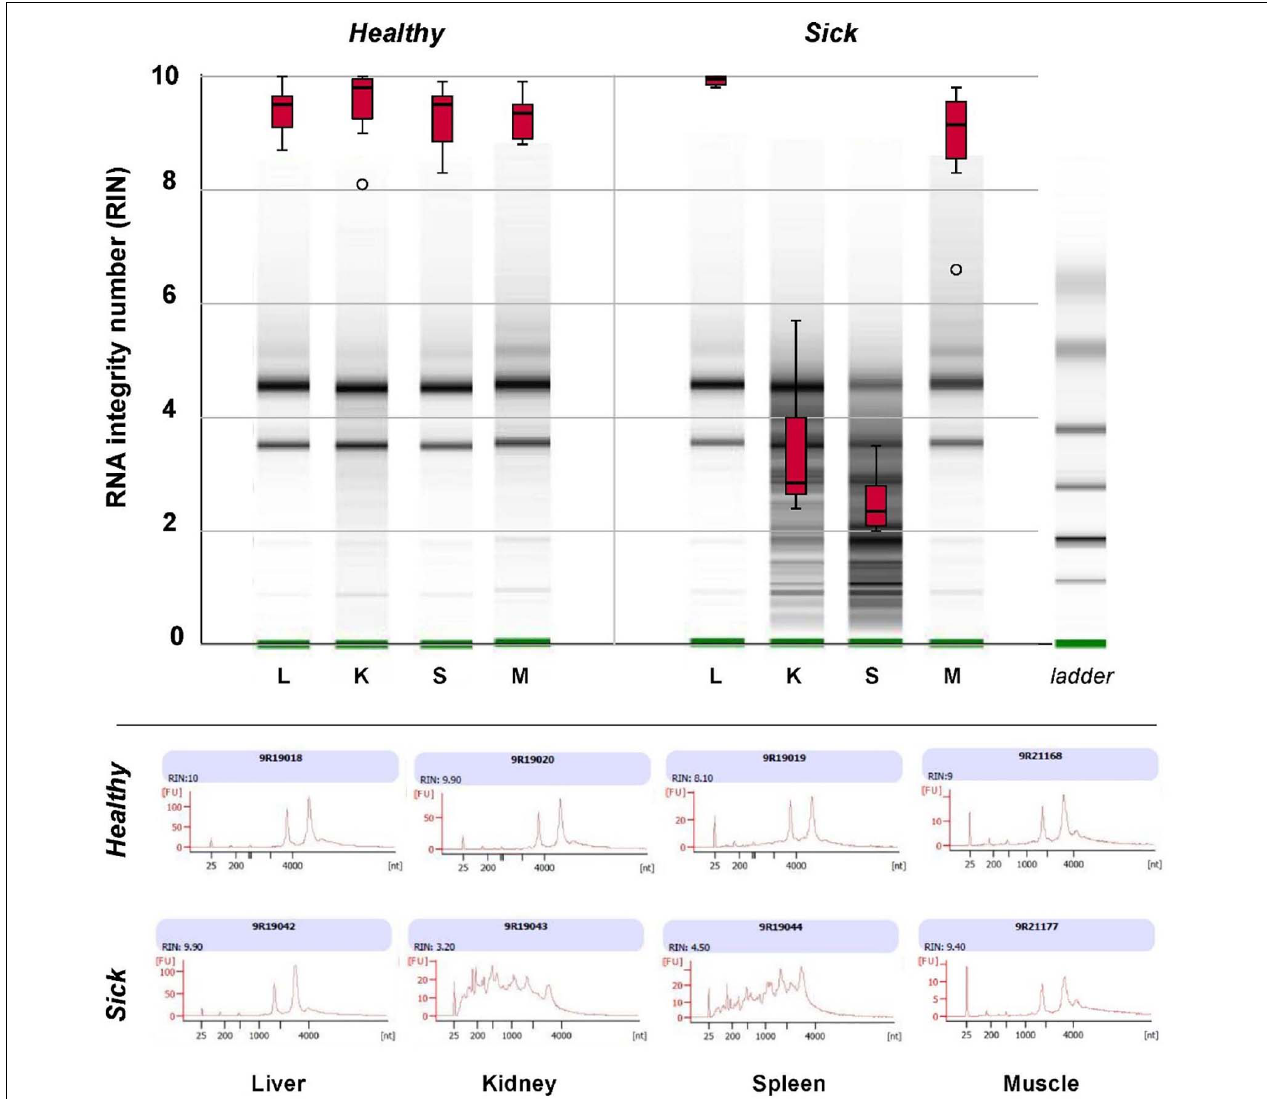
FIGURE 4 | Box plots of RNA integrity number (RIN) of total RNA extracted from liver (L), kidney (K), spleen (S), and muscle (M) tissues of eight “sick” and eight “healthy” juvenile barramundi from a sea cage farm, as determined with an Agilent 2100 Bioanalyzer RNA 6000. Nanochip assay with representative gel images (top) and electropherogram (bottom) of total RNA extracts of sick and healthy fish, indicated severe degradation in RNA extracted from kidneys and spleens of sick